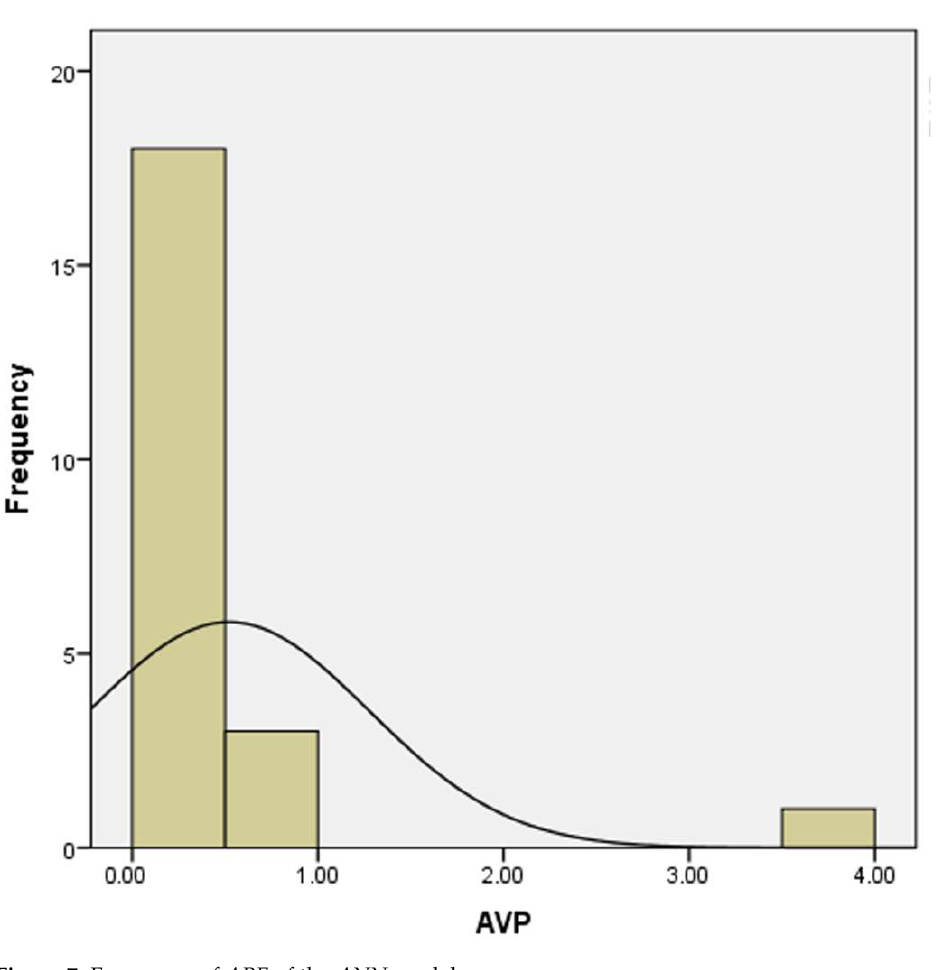
Figure 7. Frequency of APE of the ANN model. The relationship between the estimated FCC computed by the ANN model (on the horizontal axis) and the observed FCC (on the vertical axis) is depicted in Figure 8.